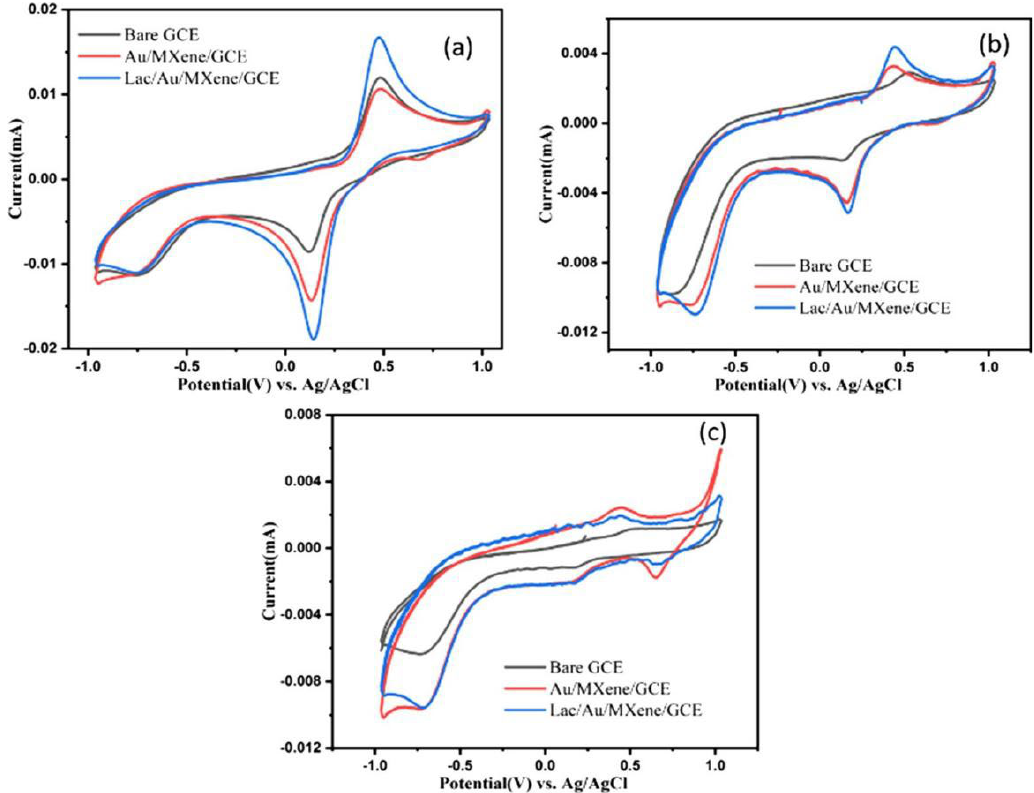
Figure 45. Comparison of the detection of catechol using bare GCE, Au/MXene/GCE and Lac/Au/MXene/GCE at a scan rate of 100 mV · s − 1 for the catechol concentration ( a ) 0.3 mM, ( b ) 0.05 mM, and ( c ) 0.01 mM